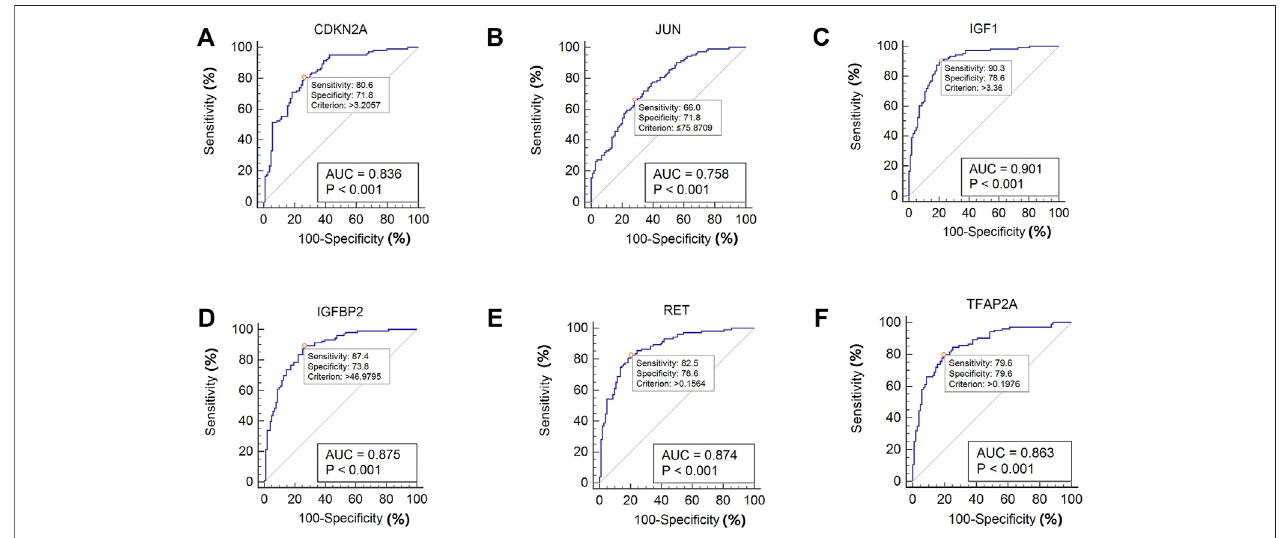
FIGURE 8 | ROC curve of the six speci fi cally expressed hub genes in IPF and healthy samples.